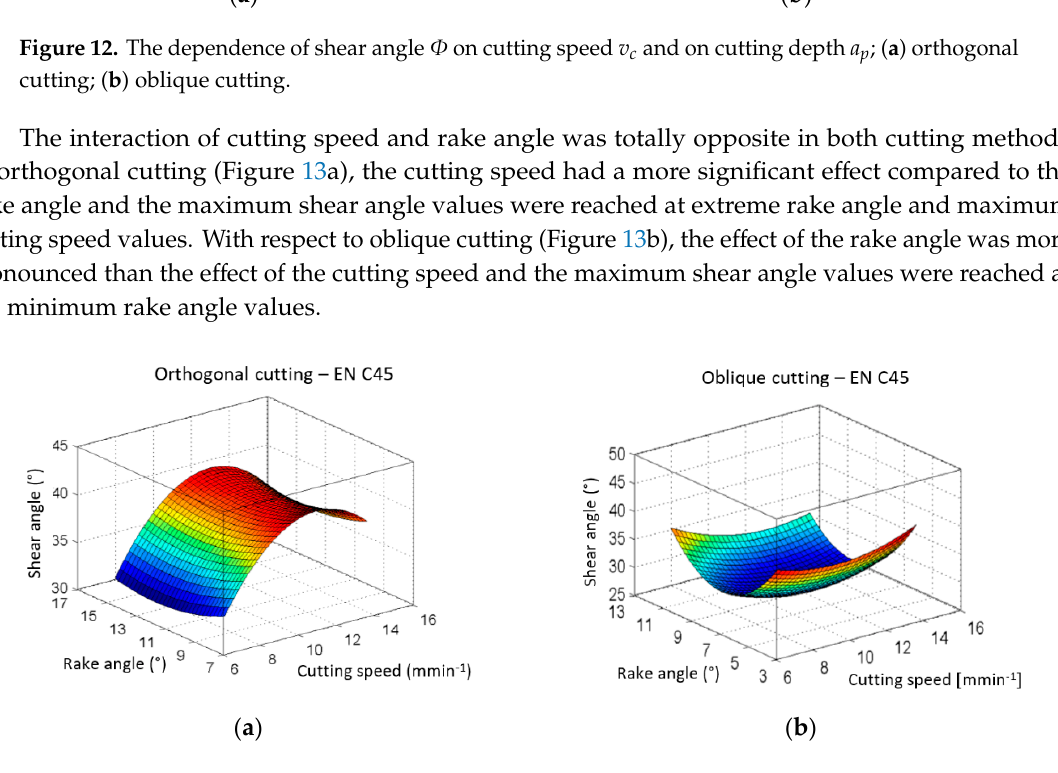
Figure 13. The dependence of shear angle Φ on cutting speed v c and on rake angle γ ; ( a ) orthogonal cutting; ( b ) oblique cutting.